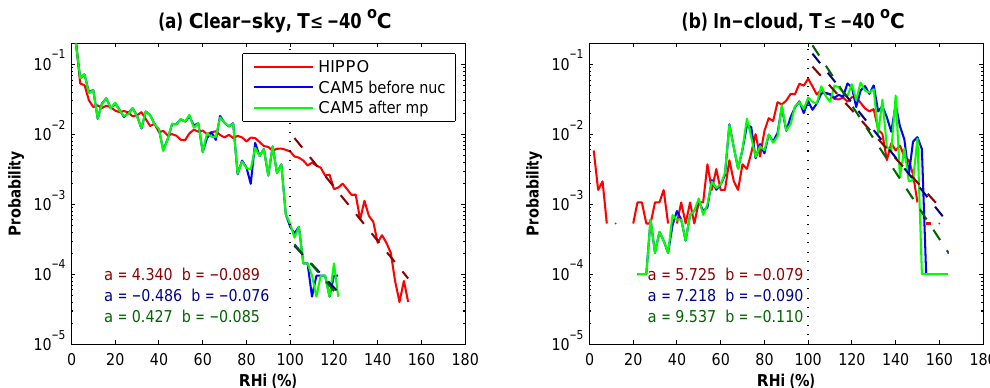
Figure 5. Observed and simulated probability density functions (PDFs) of relative humidity with respect to ice (RHi; unit: %) for T ≤ − 40 ◦ C separated into clear-sky and in-cirrus conditions. PDFs of RHi before and after cloud microphysics in the simulations are both shown. The RHi is binned by 2% for the calculation of PDF. The PDFs (when RHi>100%) follow an exponent decay: ln(PDF) = a + b × RHi. The values of a and b for each PDF are also shown in dark red (observed), dark blue (simulated before ice nucleation), and dark green (simulated after cloud microphysics). Note blue lines are mostly invisible as overlaid by green lines.